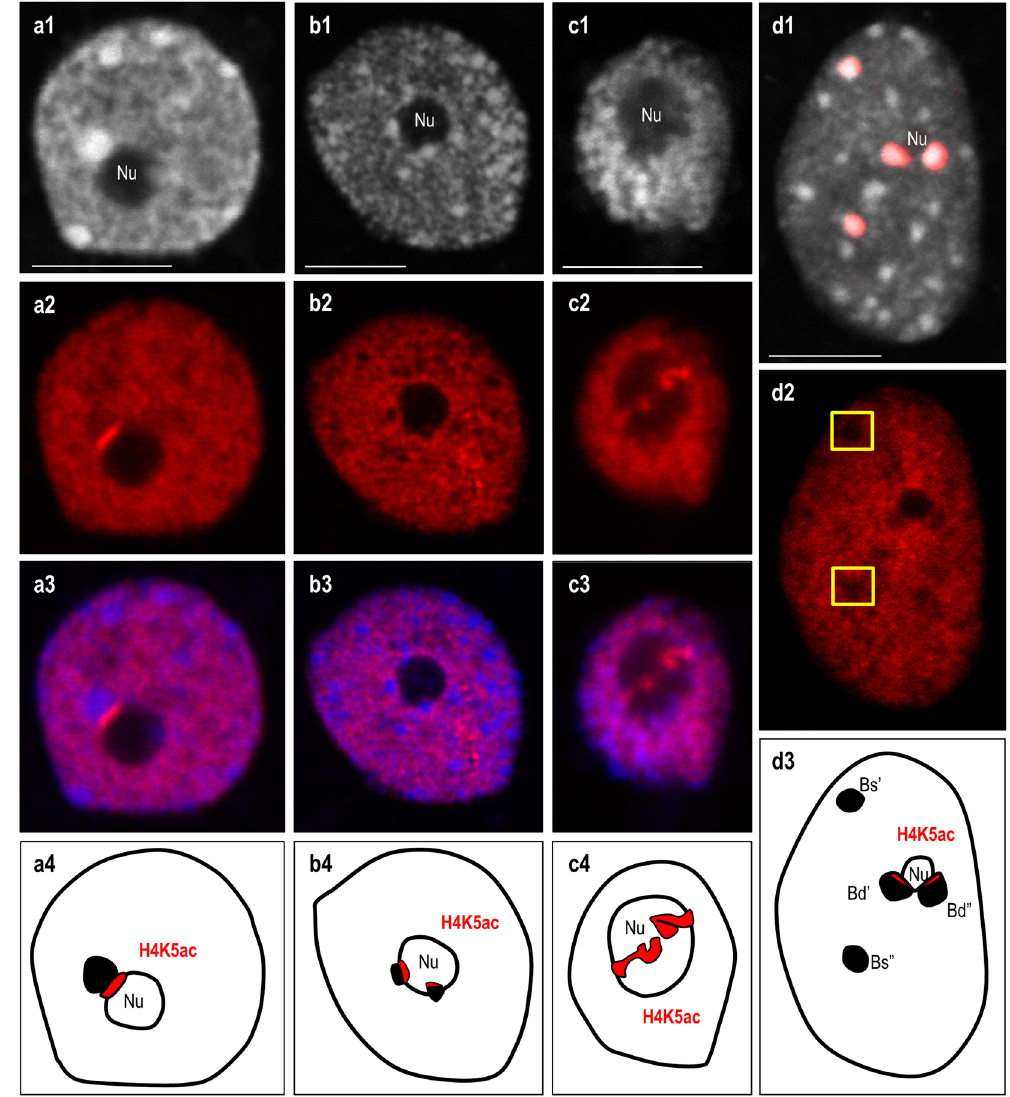
Figure 4. Immunopatterns of H4K5ac in the nuclei isolated from B. hybridum roots. H4K5ac foci distribution in nuclei with one (a1–a4) , two (b1–b4) or none (c1–c4) chromocentre(s) adjacent to the nucleolus. a1 , b1 , c1 – DAPI counterstained nuclei; a2 , b2 , c2 –H4K5ac foci distribution; a3 , b3 , c3 –superimposed channels H4K5ac foci distribution (red) and DAPI (blue); a4 , b4 , c4 –schematic representation of H4K5ac distribution in the nucleolus and adjacent chromocentres. (d1) FISH with 25S rDNA (red) as a probe in B. hybridum nucleus. (d2) H4K5ac immunostaining pattern in nucleus presented on (d1) . The locations of B. stacei -originated 35S rDNA loci are indicated by yellow insets. (d3) Schematic representation of H4K5ac foci distribution in the 35S rDNA loci superimposed from B. distachyon (Bd’; Bd”) and B. stacei (Bs’; Bs”) in B. hybridum nucleus. Nu – nucleolus. Scale bar: 5 µ